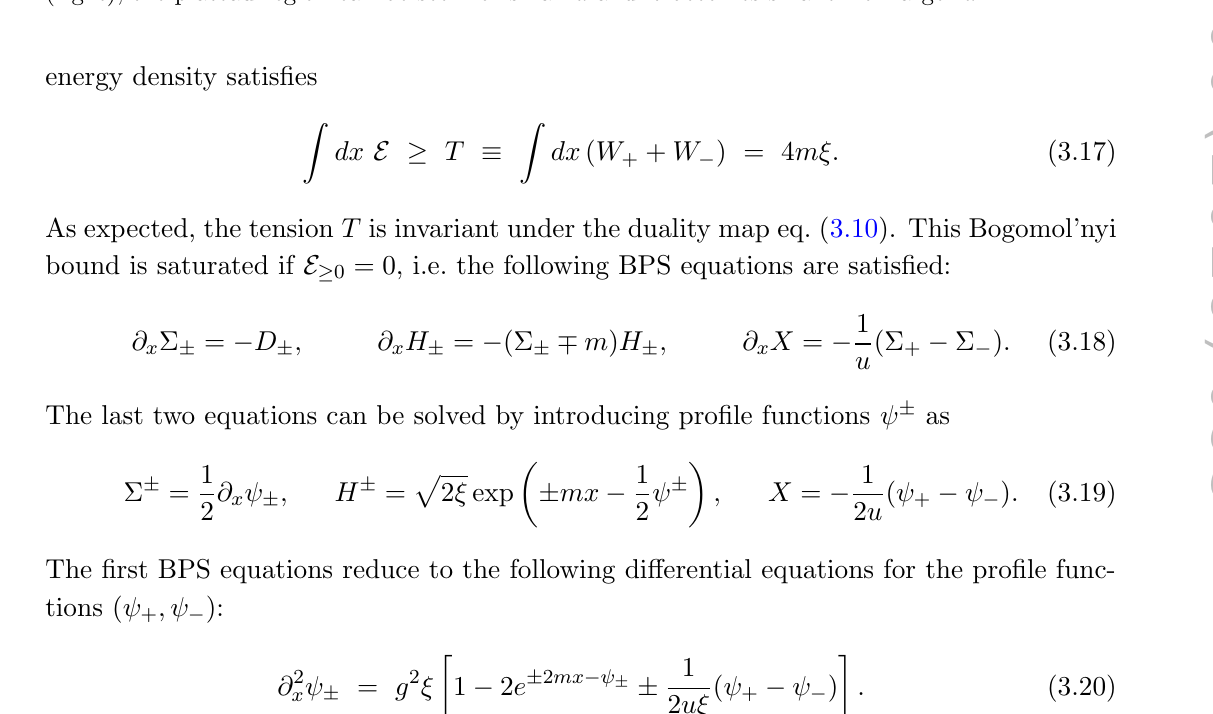
Figure 2 . Energy density pro(cid:12)les of domain wall con(cid:12)gurations. For d . m width becomes larger as we increase ~ d and a plateau appears for su(cid:14)ciently large ~ d . For d (right), the plateau region can be seen for small ~ d and it becomes smaller for larger ~ d